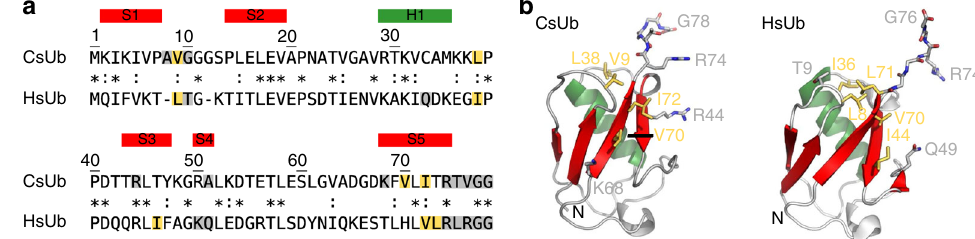
Fig. 2 Crystal structure of the ubiquitin CsUb from the archaeon C. subterraneum . Sequence alignment ( a ) and structure comparison ( b ) of CsUb and H. sapiens Ub (HsUb; PDB 1D3Z). The fi ve-stranded sheet (red) and the central helix (green) are highlighted. Residues that form important backbone (gray) or hydrophobic (yellow) interactions with CsRpn11 or AMSH are shown as sticks (see Fig. 3). In the alignment, identical (asterisks) and similar (colons) residues are indicated